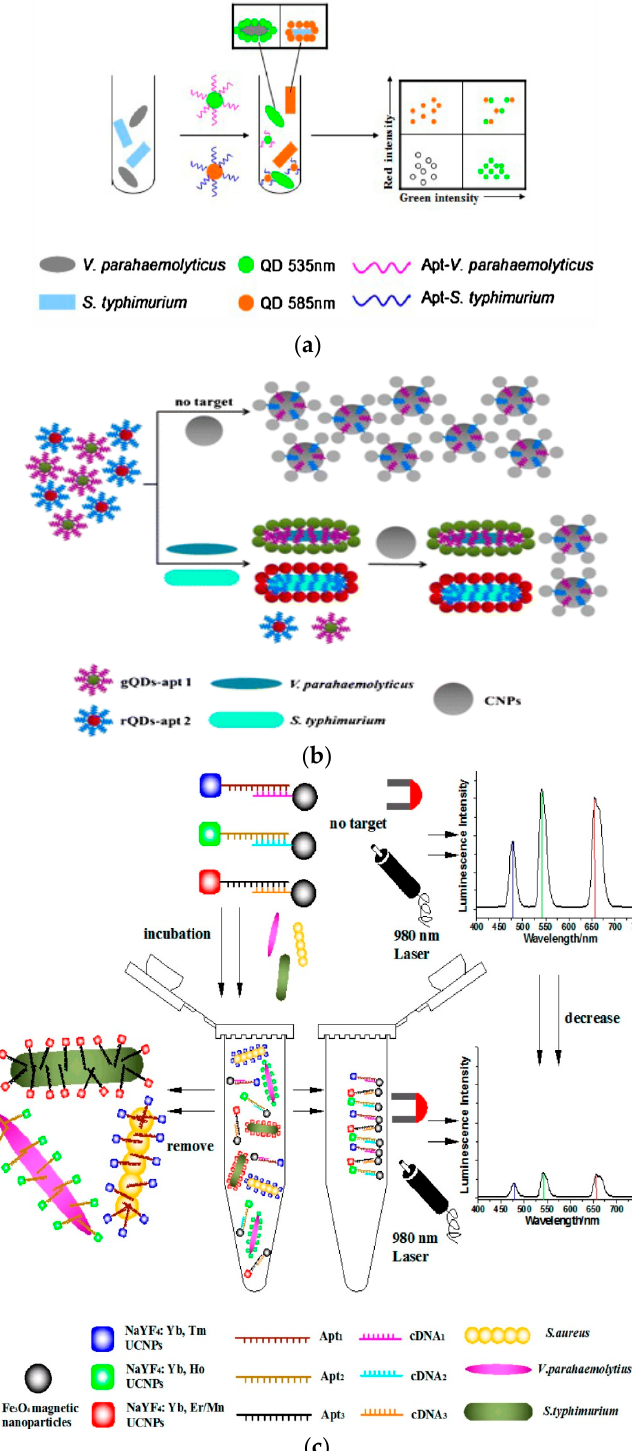
Figure 5. ( a ) Detection of Vibrio parahaemolyticus and Salmonella typhimurium using aptamer-functionalized QDs and flow cytometry (adapted with permission from [36]); ( b ) FRET based measurement b (adapted with permission from [31]); ( c ) shows multiplexed detection of three types of bacteria by three different aptamer-based upconversion rare earth NPs. The detection is based on the luminscence signals of free NPs after separation from bacteria mixture (adapted with permission from [39]. Copyright (2014) American Chemical Society).